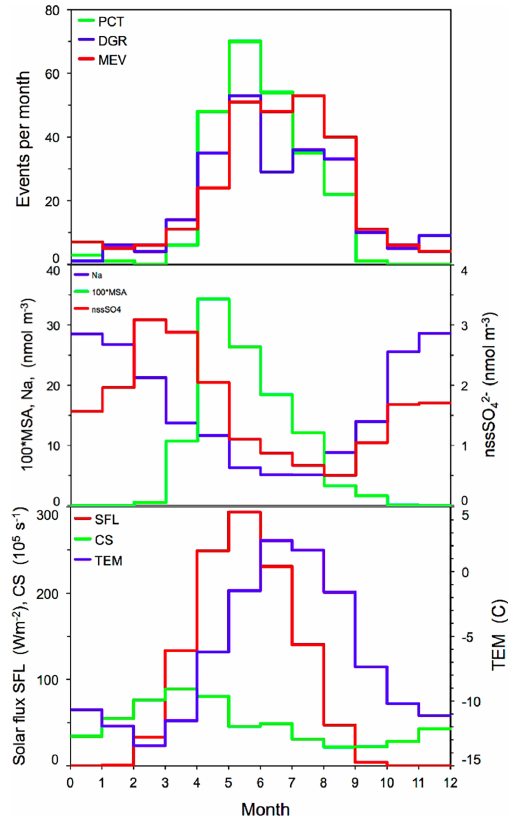
Figure 6. Top: monthly numbers of new particle formation events according to the three approaches, summed up over the whole pe- riod of 10 years. PCT: upper percentile of N 25; DGR: diame- ter growth; MEV: multiple-size events. Center: average seasonal distribution of particle composition in nmolm − 3 . Na = sodium, nssSO 4 = nssSO 2 − , MSA is methane sulfonate times 100. Bottom: 4 monthly average solar flux (SFL; red, Wm − 2 ) , and temperature (TEM; blue ◦ C), and condensation sink (CS; 10 5 s − 1 ) , at Mt. Zep- pelin,